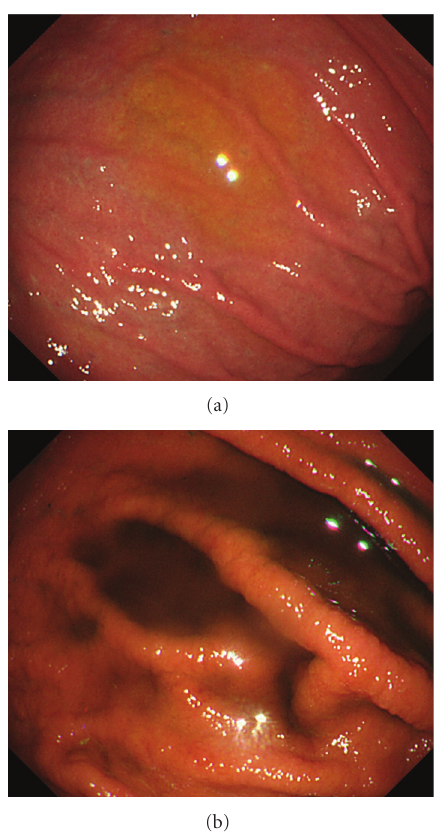
Figure 1: Gastric mucosal changes occurred after splaying Lugol’s iodine solution in a 78-year-old man. (a) Endoscopic view of the greater curvature of the gastric body showed no fold thickening. (b) Endoscopic view after spraying Lugol’s iodine solution showed fold